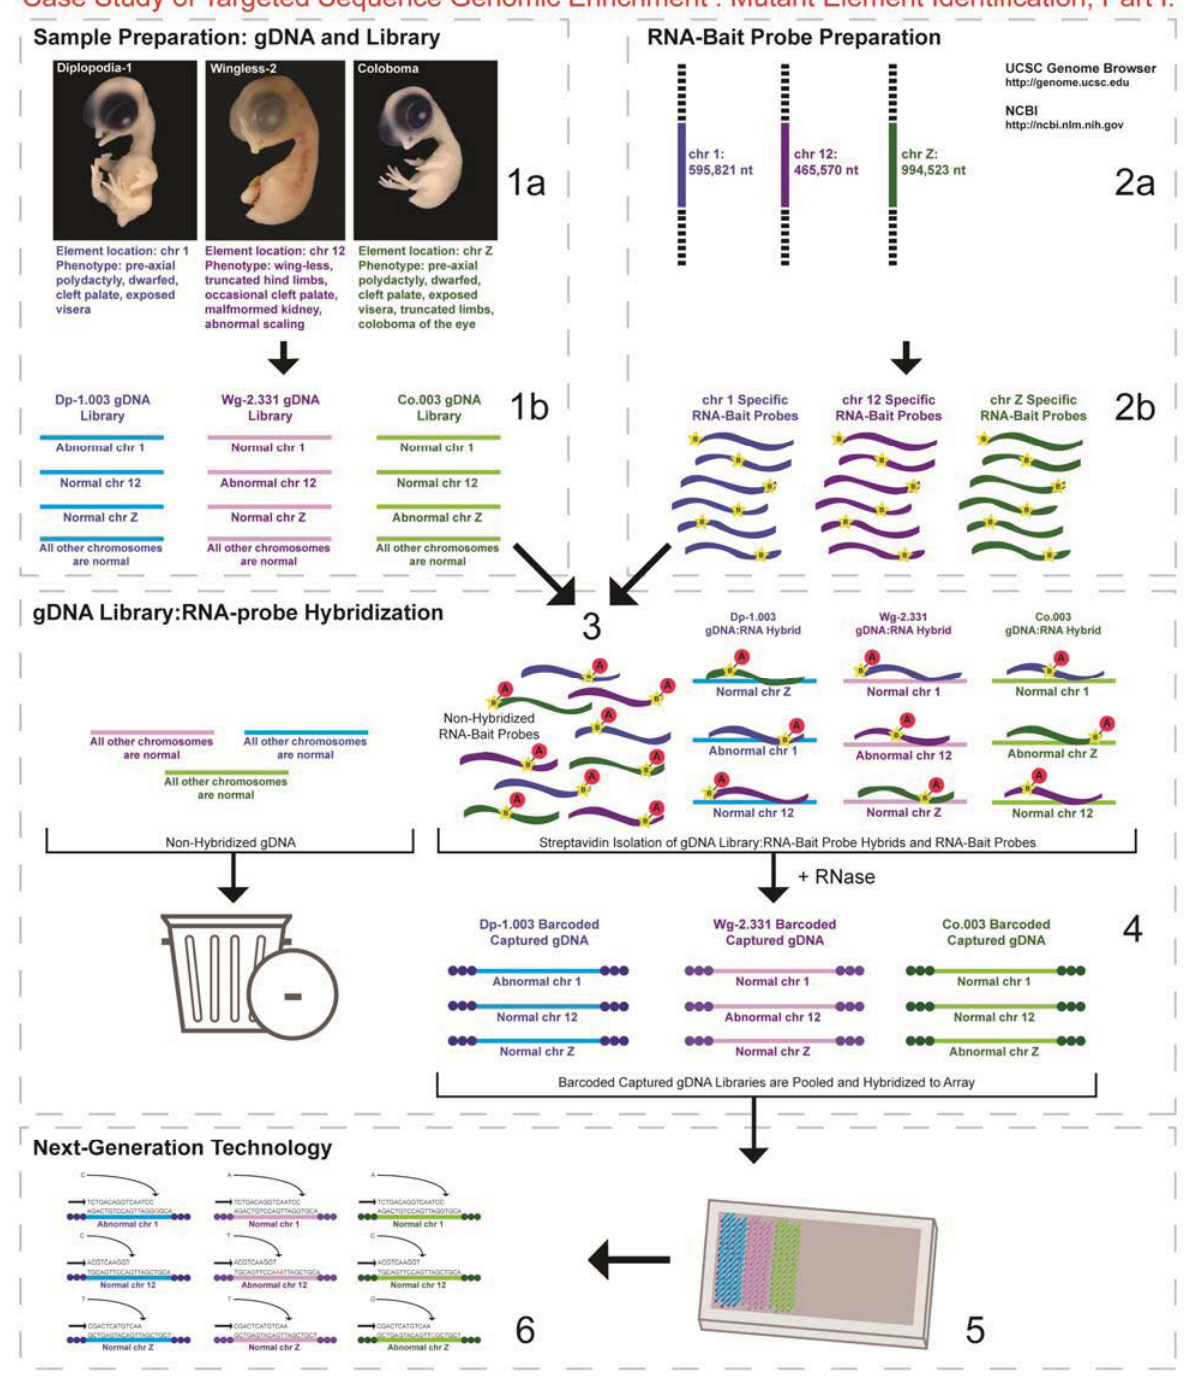
Figure 1. Targeted Sequence Genomic Enrichment Methodology, Part I. Targeted genomic capture enrichment paired with next-generation sequencing technology was utilized to sequence, in their entirety, the three chromosomal regions associated with three developmental mutations in the chicken. Approximate timeline from contract with the service provider to transfer of data (steps 1–6) was ~6